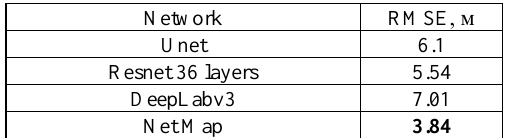
Table 6. NetMap architecture comparison using full training pipeline